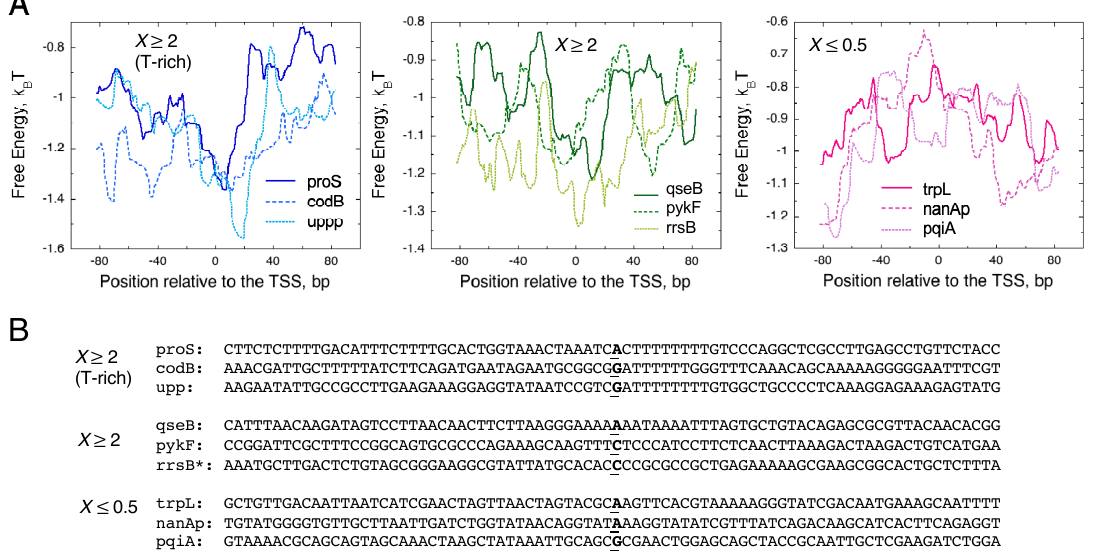
Figure 6. The relation between the FEINC (free energy) landscapes ( A ) and DNA sequences ( B ), representing examples of sequences from the three groups characterized by the ratio X = nrt ( ∆ greAB ) / nrt (WT). The first group corresponds to X ≥ 2 with T-rich signal, the second group corresponds to X ≥ 2 without T-rich signal, and the third group corresponds to X ≤ 0.5, respectively. Each group has three representative promoters in which TSS of the panel B is indicated by bold font with underline. Note that the rrsB promoter, indicated by asterisk, has X = 3.81 but was excluded from sequence analyses shown in Figures 3–5 due to the redundant property of the rRNA gene.